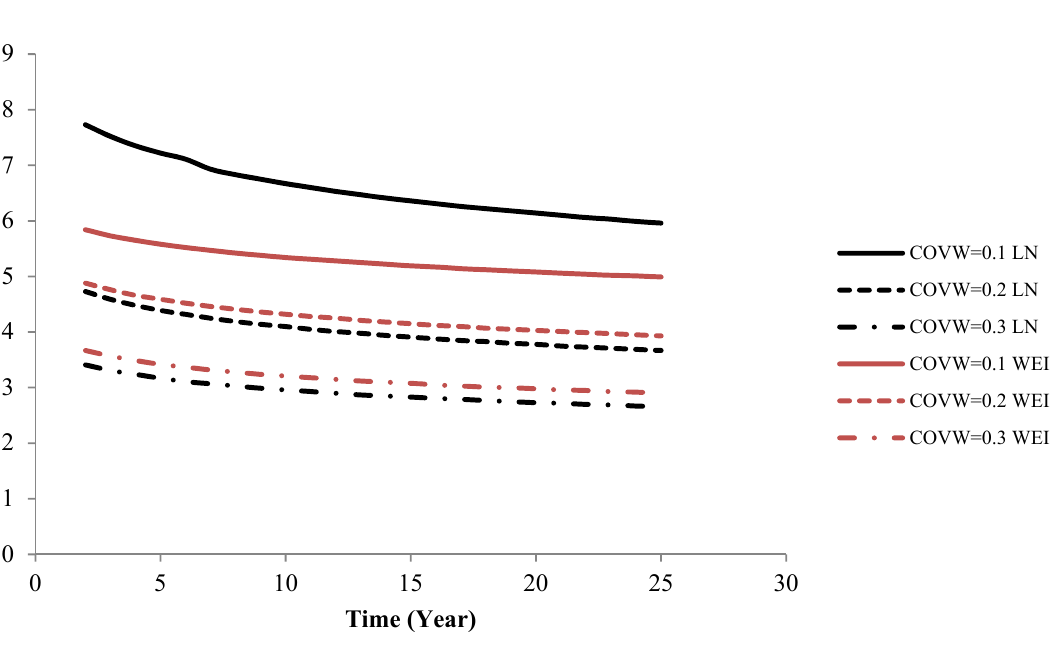
Figure 5. Annual reliability index for partial safety factor Weibull and log-normal models. Test D21 T150 R = − 1.